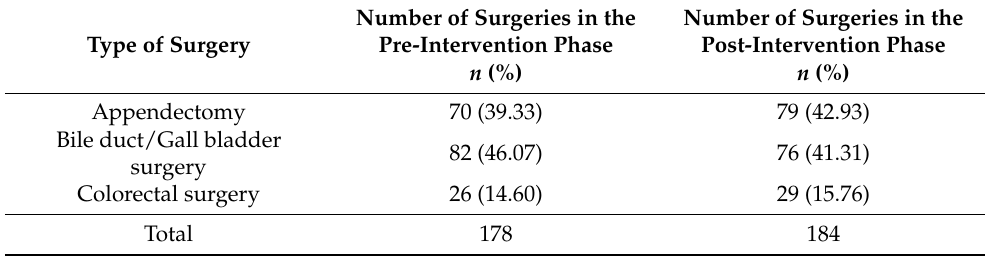
Table 2. Surgeries performed on the patients.